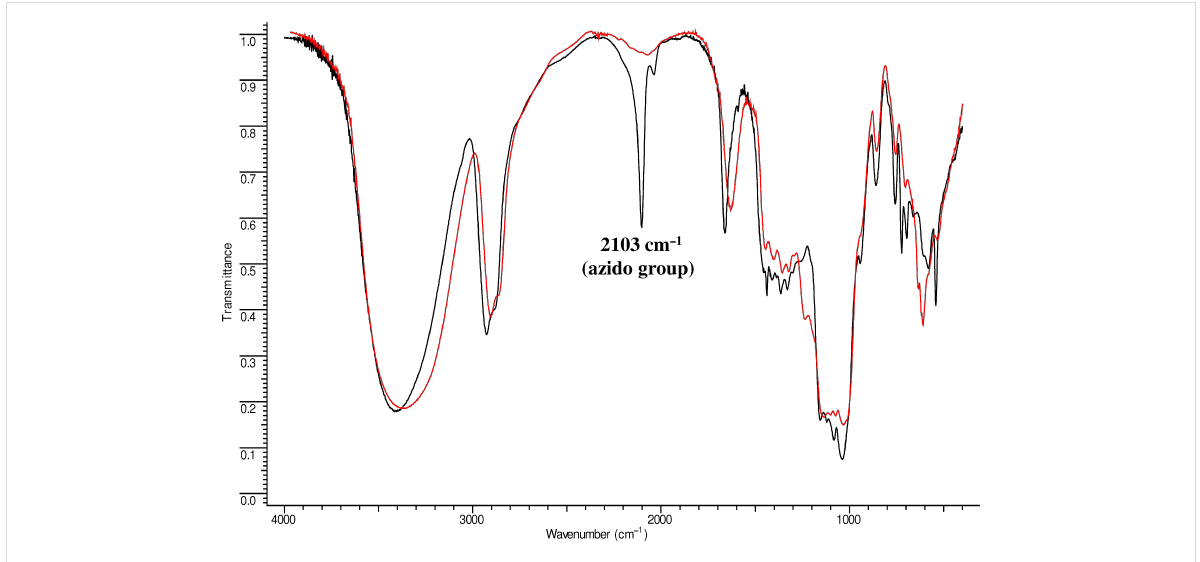
Figure 3: IR spectra of compound 1 (black line) and compound 2 (red line) showing the disappearance of the azido peak after reduction.